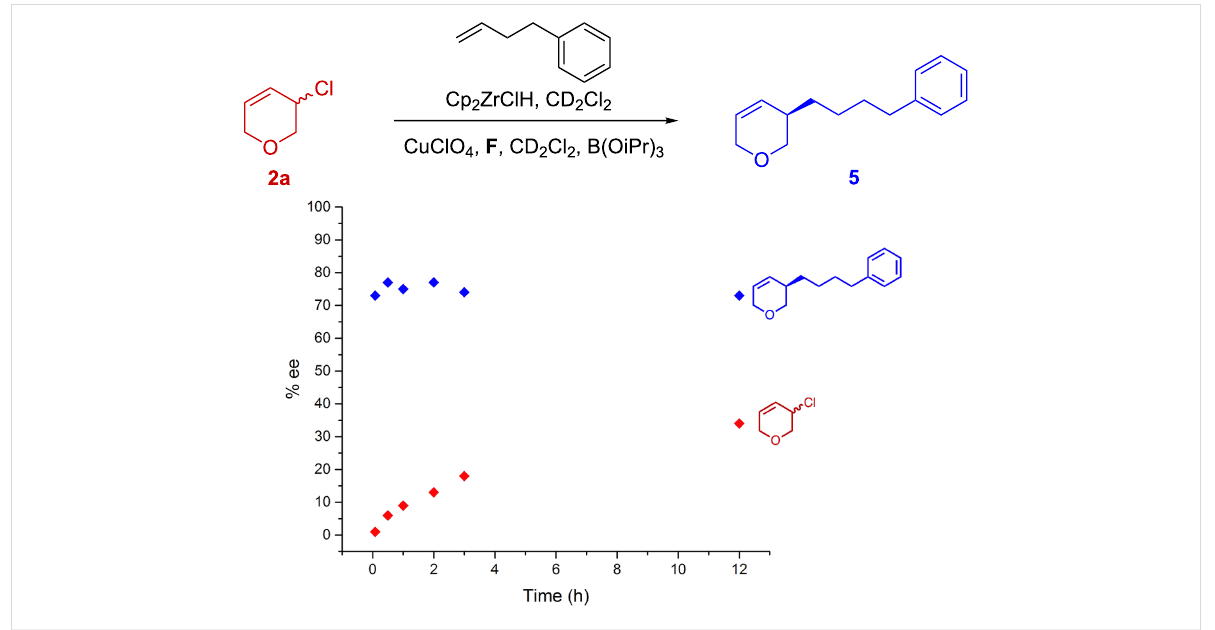
In the case of allyl phosphate 2d , the system appears to lack re- activity and the reaction quickly dies, so that 10 (Figure 3) is formed with poor conversion, and we speculate that the phos- phate leaving group inhibits the catalyst which would explain why only ~10% of product is